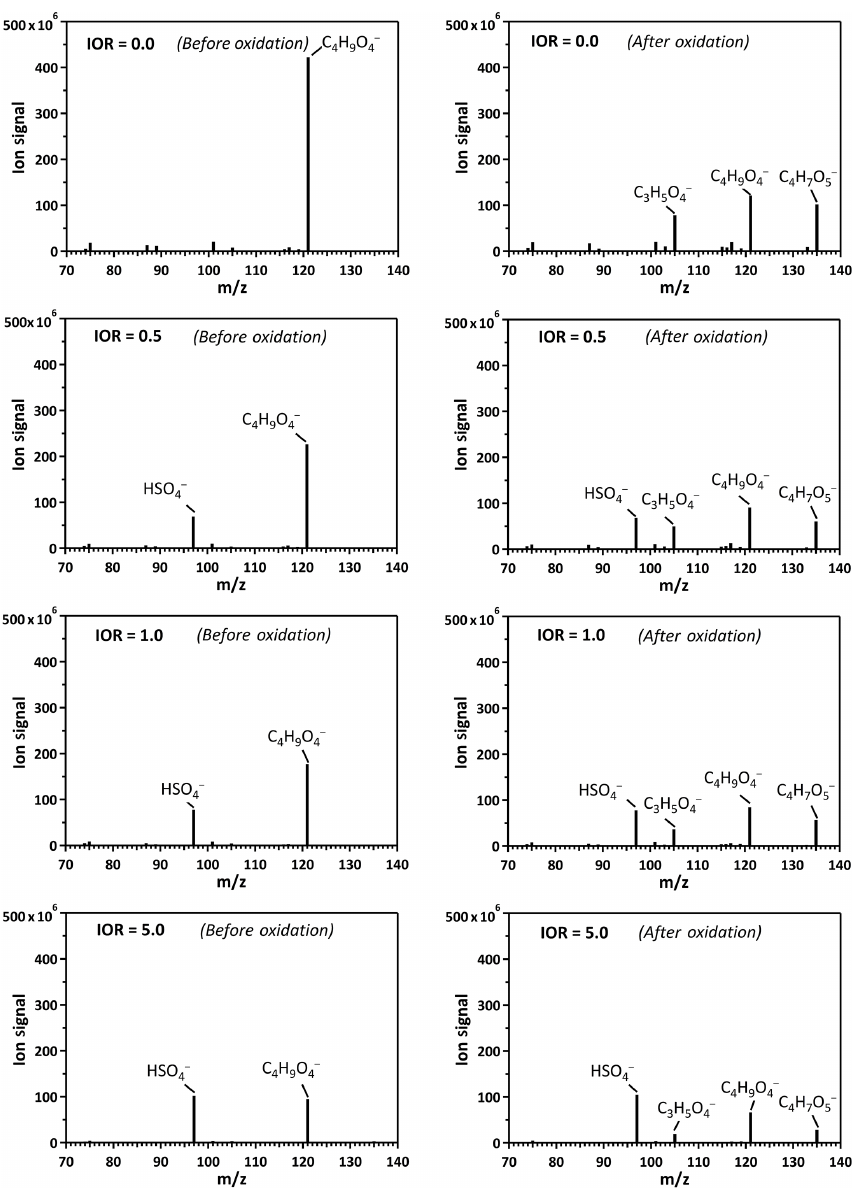
Figure 1. Particle DART mass spectra for erythritol particles and erythritol–AS particles at different IORs before and after oxidation (at the highest OH exposure of ∼ 2 . 29 × 10 12 moleculecm − 3